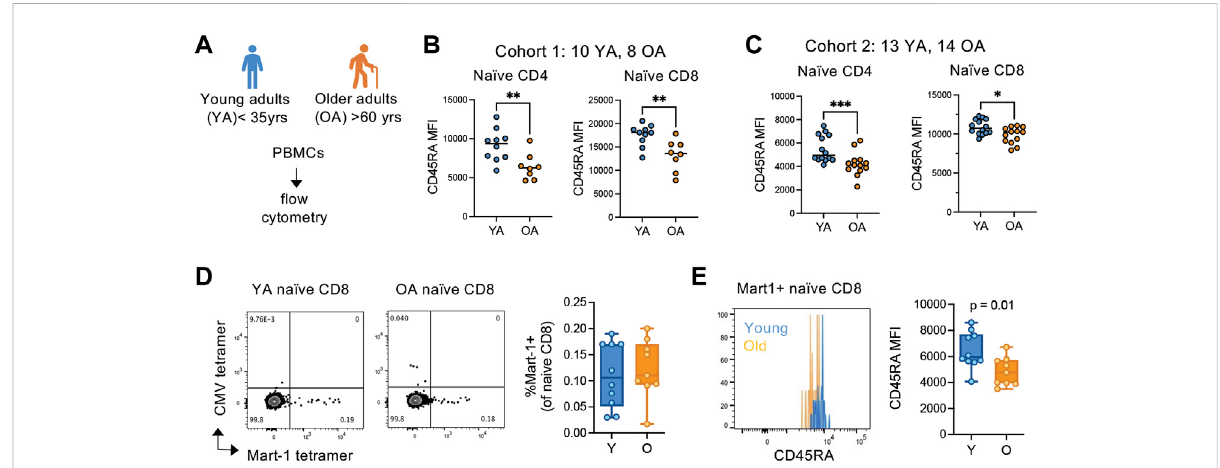
FIGURE 3 CD45RA expression is globally reduced on antigen-inexperienced naïve T cells in older adults. (A) Overview of young (YA; < 35 years old) and older (OA; > 60 years old) adult cohort design for peripheral blood mononuclear cell fl ow cytometry. Flow analysis was done same day, same instrument for each independent cohort. (B) Cohort 1 (YA = 10, OA = 8) and (C) cohort 2 (YA = 13, OA = 14) analysis of CD45RA expression on the surfaceofnaïveCD4andCD8Tcells. (D) Frequenciesofand (E) CD45RAMFIonMart-1-speci fi cnaïveCD8Tcellsfromyoung( n